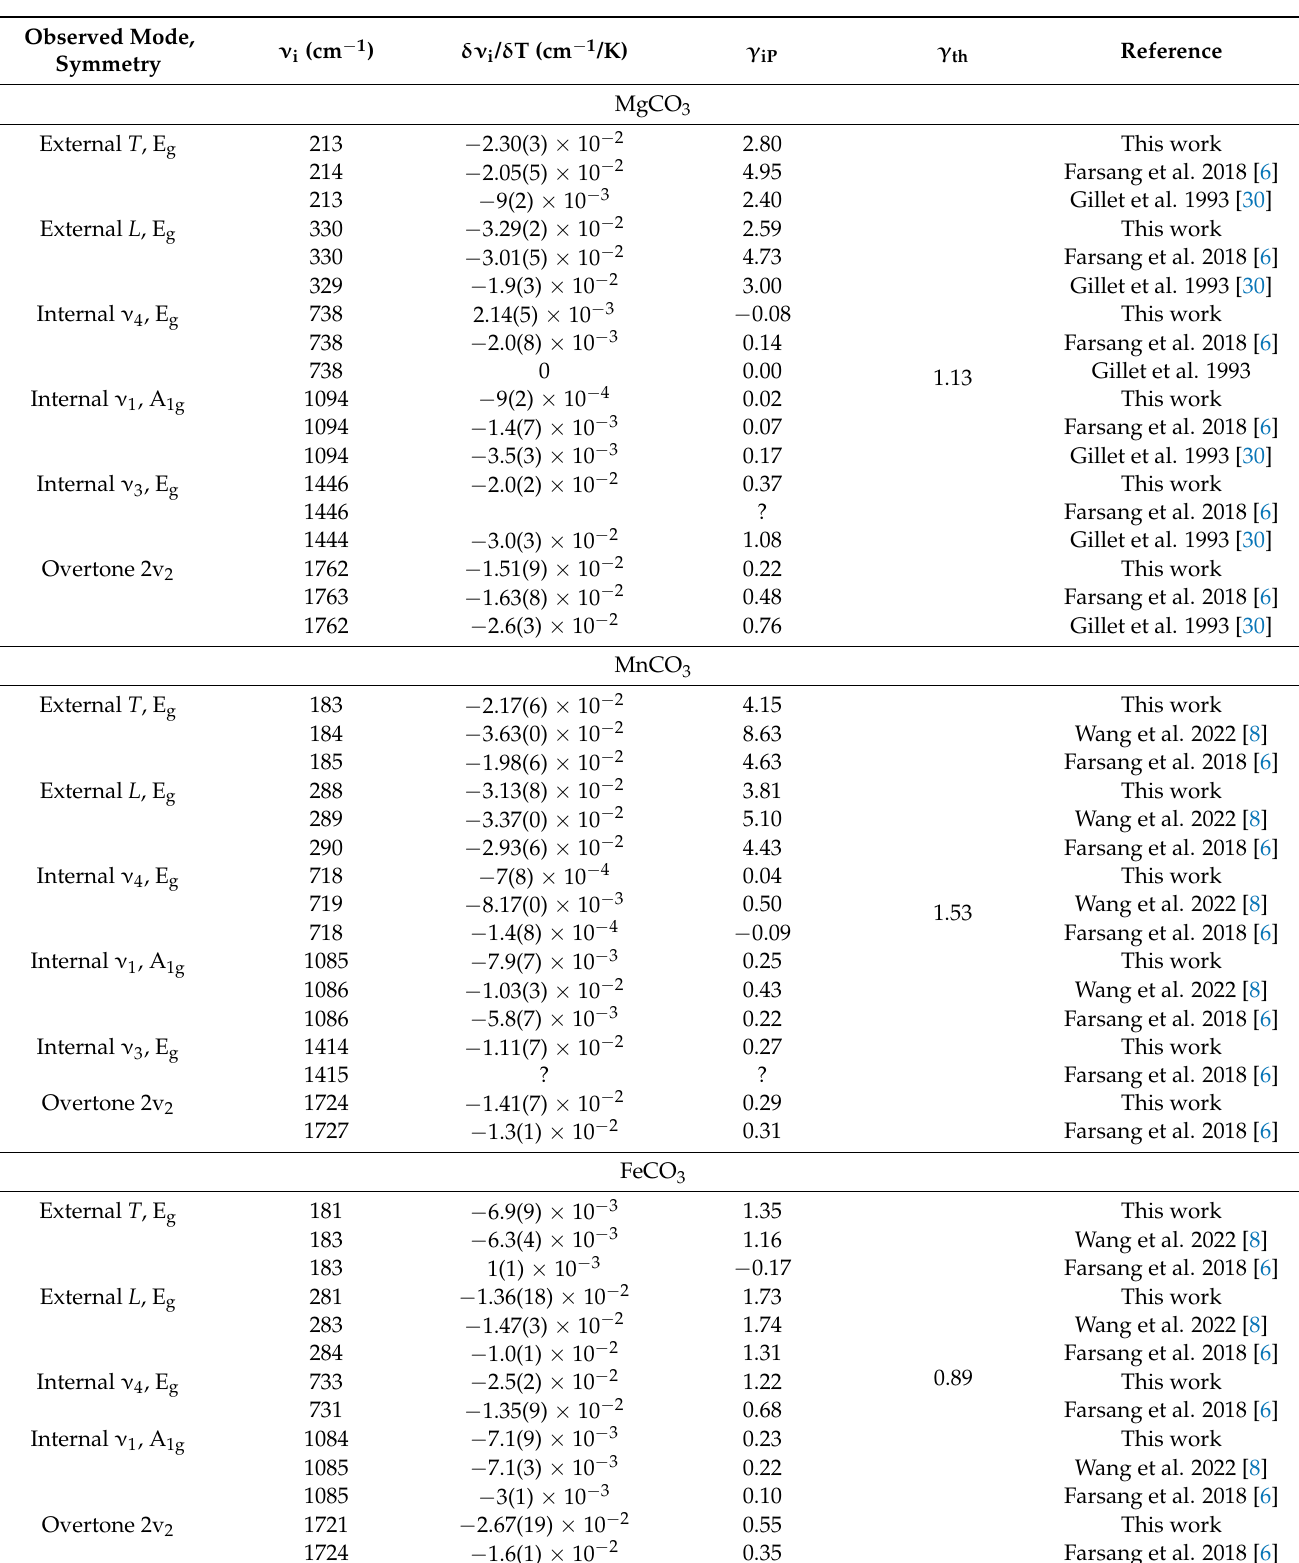
Table 2. Modeled vibrational parameters and thermal Grüneisen parameters of MFM, MF, FM, MM, FeCO 3 , MgCO 3 , and MnCO 3 at high temperature. Data from Farsang et al., 2018, Gillet et al., 1993 and Wang et al., 2022